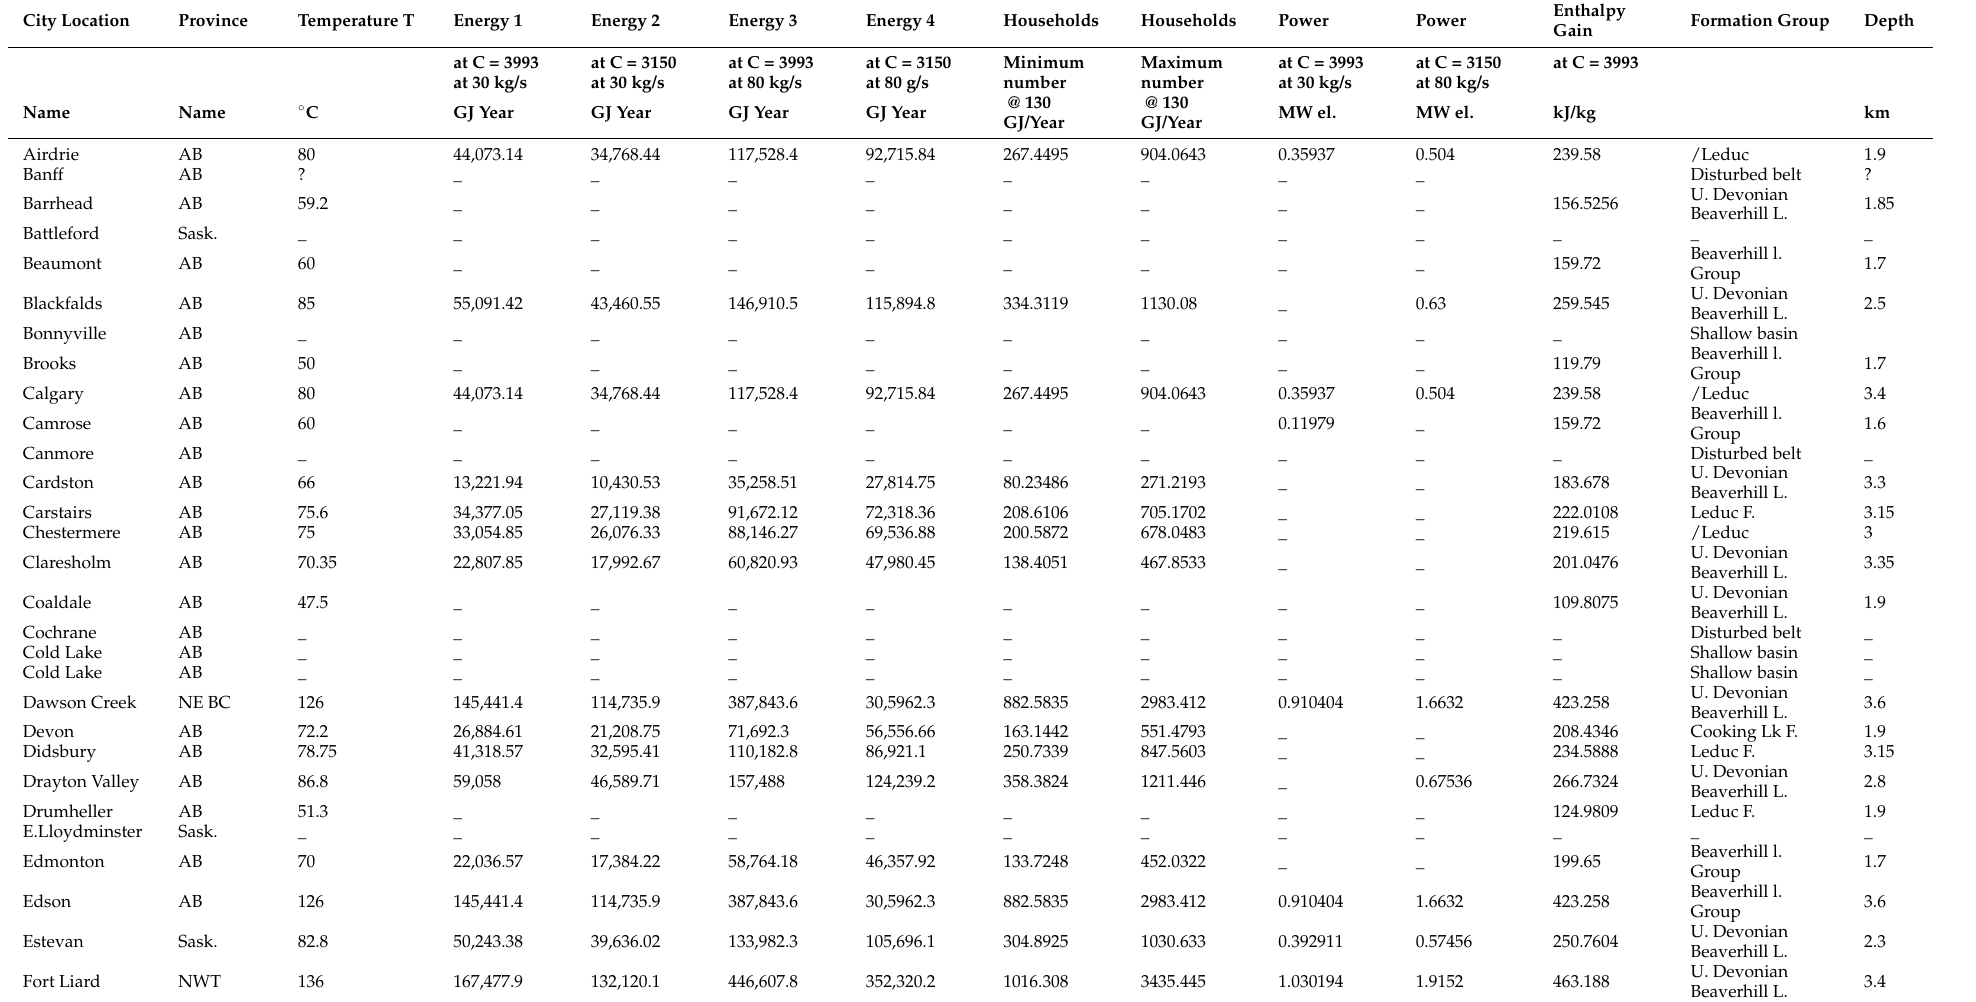
Table A2. WCSB >3 k populations centers geothermal prospects summary—Upper Devonian Beaverhill Lake Group—Energy, Enthalpy, Power, Number of direct deep geothermal energy heated households